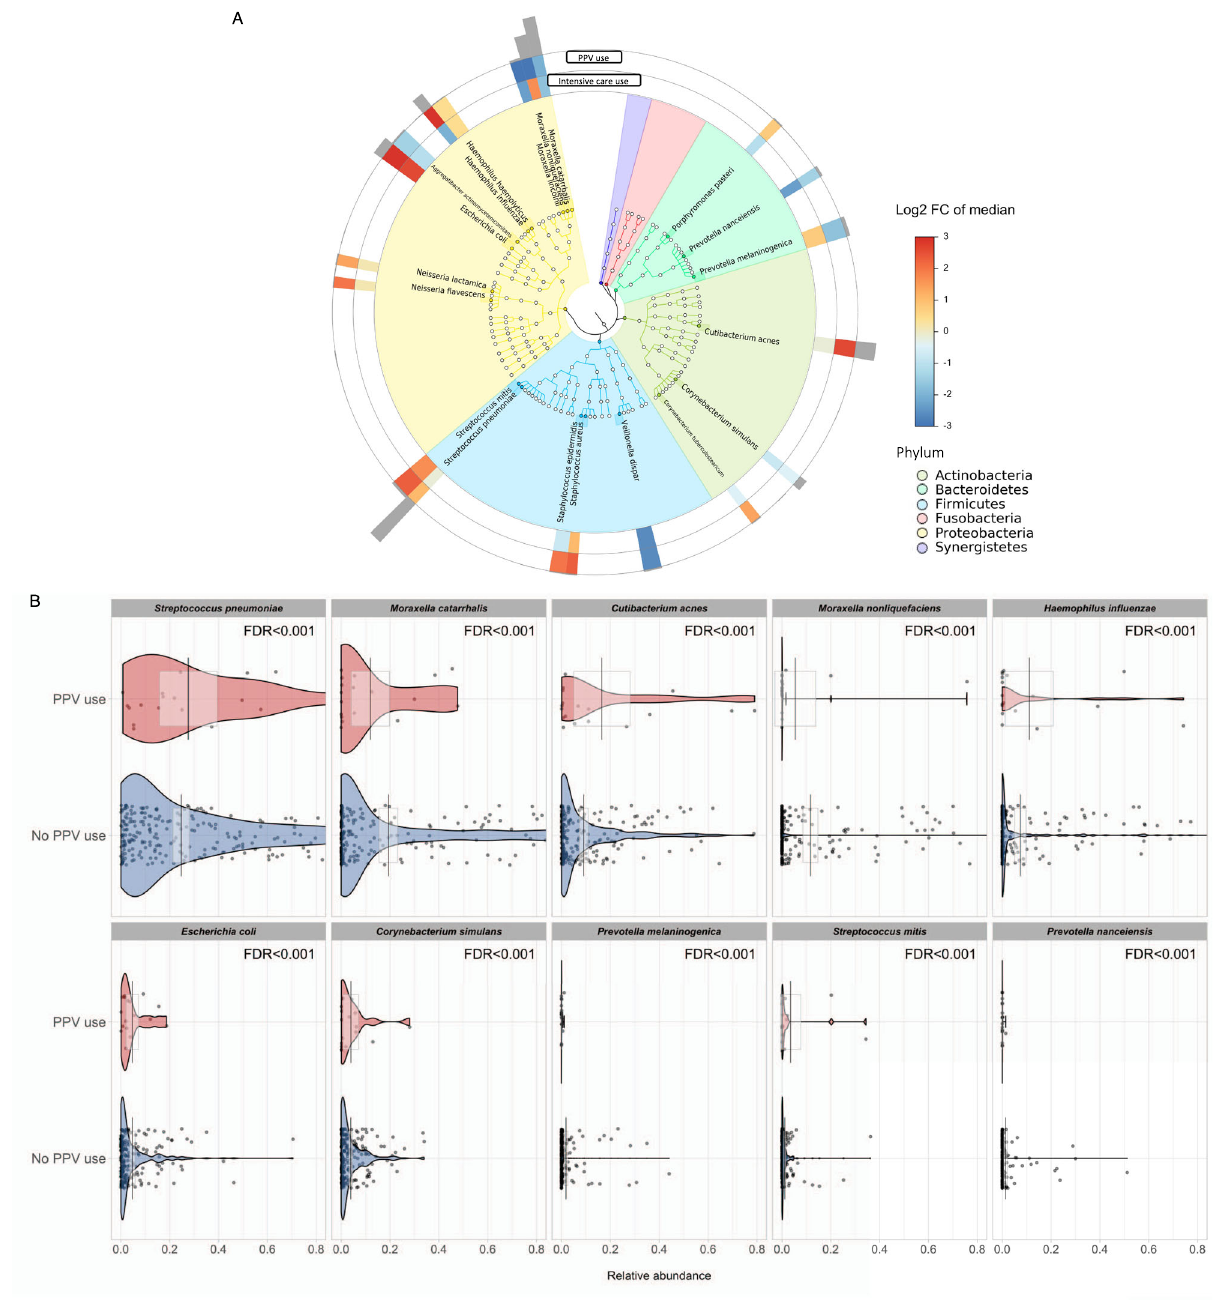
Fig. 3 | Relationship of abundant microbial species with the risk of higher severity in infants hospitalized for bronchiolitis. A Phylogenetic plot of top 20 most abundant microbial species in the nasopharyngeal airway of infants hospi- talizedforbronchiolitis.Thecolorsintheinnercircleannotatethesixmajorphyla. The colors in the two internal rings represent the magnitude of the association between the relative abundance of each species and higher severity (PPV use and intensive care use) outcomes. Greyscale bars on the outside of the circular graph are proportional to the microbial species ’ mean relative abundance. B The pirate